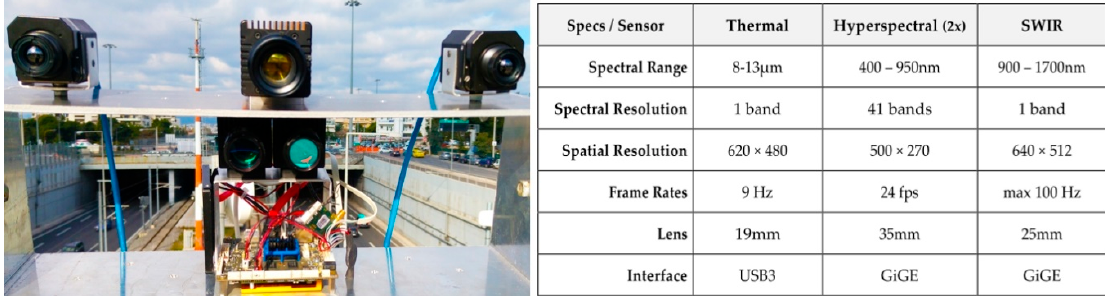
Figure 2. The multisensor system on the left with the thermal (top left and right), the SWIR (middle top) and the two hyperspectral snapshot sensors (middle bottom) on top of the single board computer with the embedded processor. The sensor specifications are presented in the table on the right.